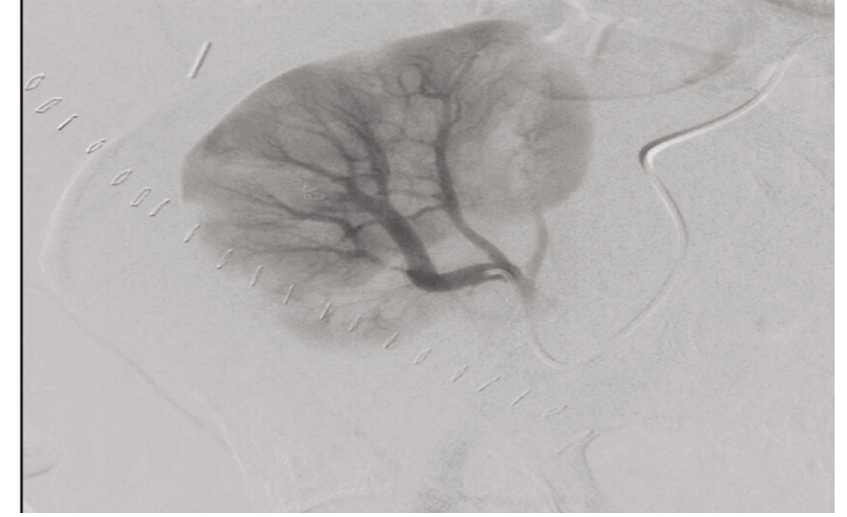
Figure 4: Postembolization arteriogram demonstrates resolution of the venous drainage